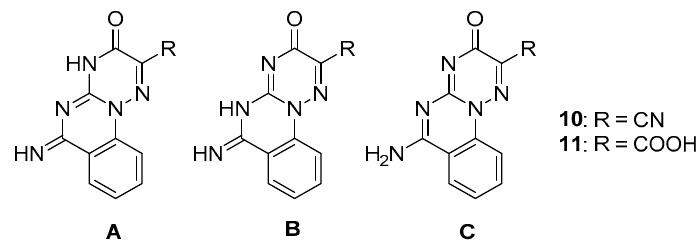
Figure 4. Possible tautomeric forms of 1,2,4-triazino[2,3- a ]quinazolines 10 and 11 .